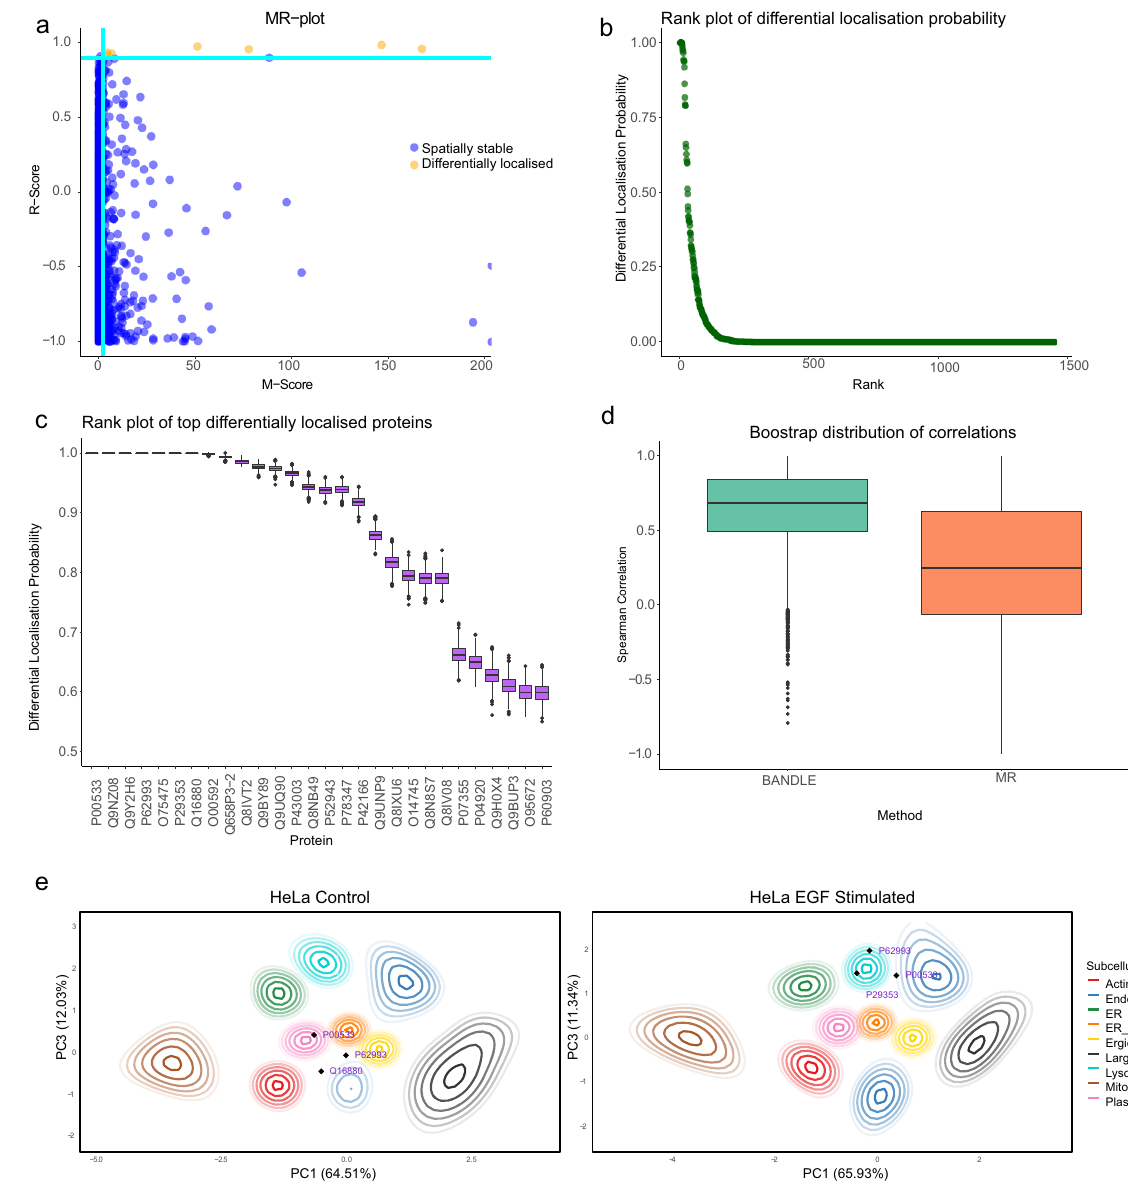
Fig. 4 | Analysis of an EGF stimulation dataset. a An MR-plot where dark green lines are drawn at suggested threshold and hits are highlighted in orange. b BANDLE rank plot showing the distribution of differentially localised proteins. c The top differentially localised proteins from BANDLE plotted with uncertainty estimates. d Bootstrapdistributionsofcorrelationswithaphosphoproteomictime- course experiment. The BANDLE con fi dence intervals differ signi fi cantly from 0, while the MR method do not. 5000 bootstrap samples were used with data pre- sentedasmedianswithnotchesrepresentingtheinterquartilerange(IQR),andthe